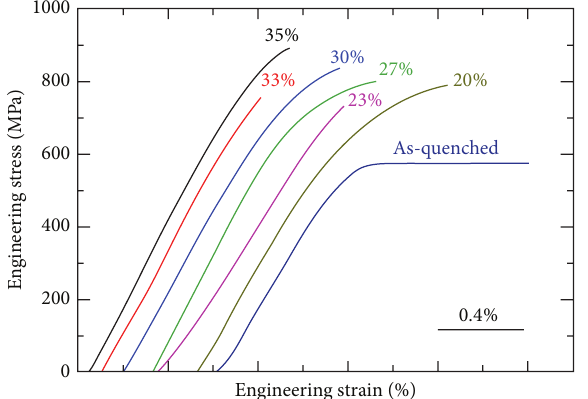
Figure 6: Tensile engineering stress-strain curves of as-quenched ribbon and ribbons with different cold rolling reduction.